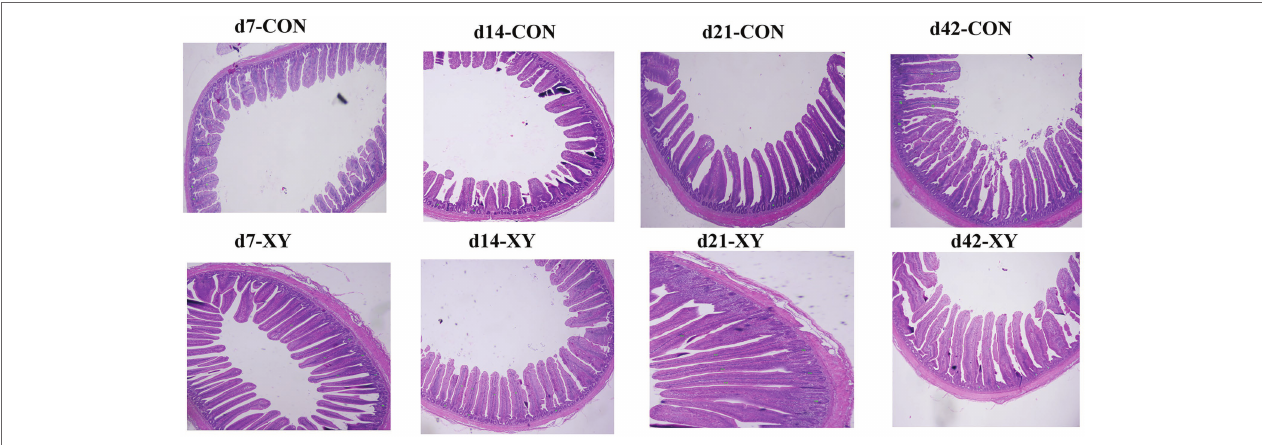
FIGURE 1 | Representative histological micrographs of ileum in broilers. CON is AT-xynA un-supplemented group; XY is 4,000 U/kg AT-xynA supplemented group.